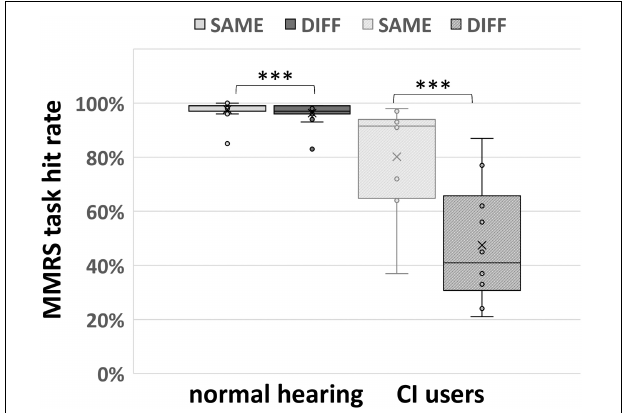
FIGURE 3 | MMRS task performance (separating SAME and DIFF conditions) of 15 normal hearing participants and 10 CI users. The box plots display the minimum, maximum, median, first quartile (25th percentile), and third quartile (75th percentile), respectively. In both normal hearing and CI user groups, participants performed significantly better in SAME comparing DIFF condition ( ∗∗∗ indicates p < 0.005, paired and two-sided Wilcoxon signed rank